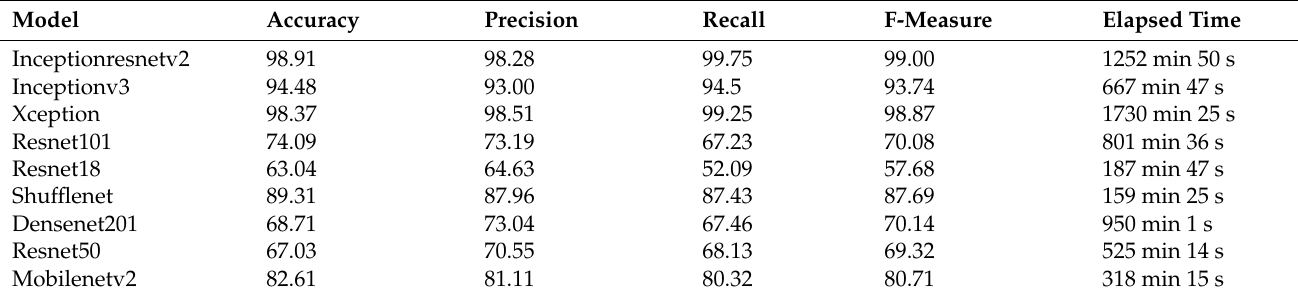
Table 3. Average classification